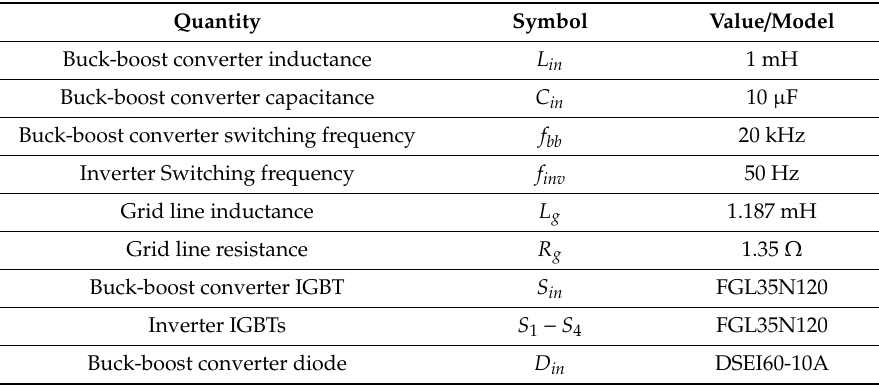
Figure 1. Schematic of experimental setup. Table 1. Values of the setup characteristic elements.